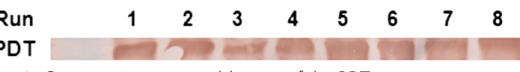
Fig. 2 Comparative western blotting of the PDT protein; experimental runs 1–8